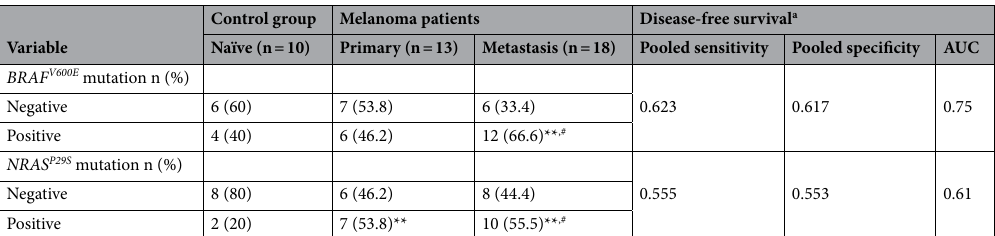
NRAS P29S mutation n (%) Positive 2 Table 2. BRAF and NRAS mutation variables in study patients. Data are presented as mean ± SD for all others. Naïve, healthy subjects with normal skin. BRAF V600E B-Raf proto-oncogene, serine/threonine kinase with valine ‐ to ‐ glutamic acid substitution at position 600, NRAS P29S Neuroblastoma RAS viral [v-ras] oncogene homolog with proline-to-serin acid substitution at position 29. * p < 0.05 and ** p < 0.001 vs the naïve group; # p < 0.05 and ## p < 0.001 vs the primary group. a The disease-free survival (DFS) was analyzed using the Kaplan– Meier method, log-rank test, and Cox proportional hazard model. The area under the curve (AUC) of receiver operating characteristic (ROC) an analyzed by using spearman’s rank correlation coefficient test helped determine the relationship between two sensitivity (ordinate) and 1-specificity (abscissa).